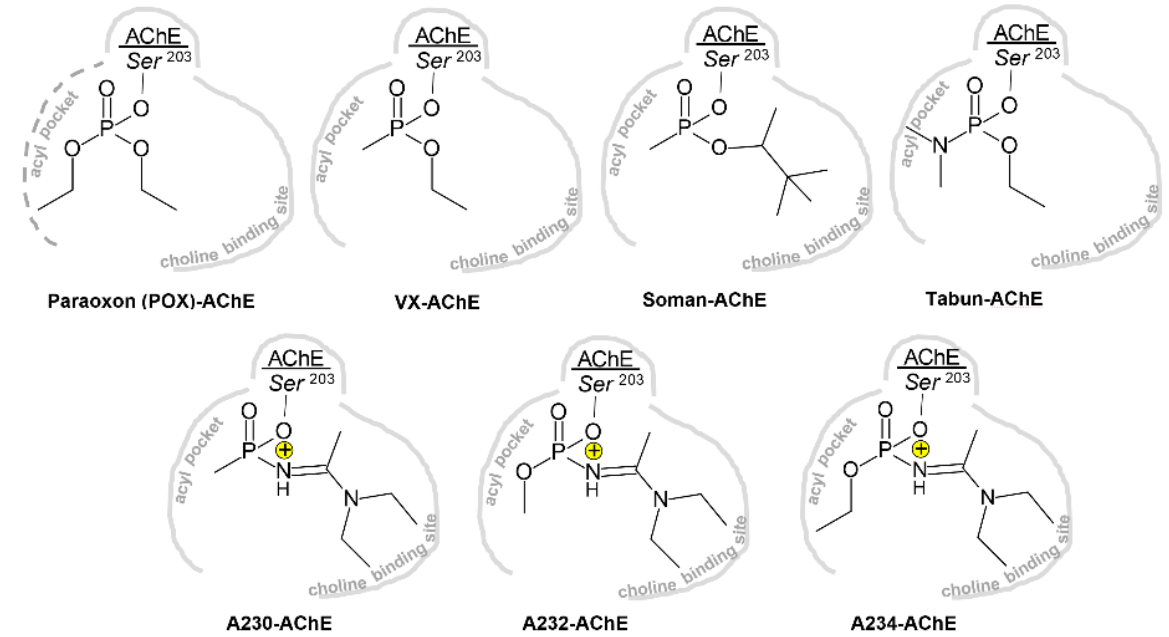
Figure 2. Schematic representation of OP-hAChE conjugates formed by OPs from Figure 1. Orientations of substituents on phosphorus atoms with respect to “acyl pocket”, active Ser203 and “choline-binding site” of hAChE were inferred from respective X-ray structures. Protonation of the imido nitrogen in A-type nerve agent inhibited conjugates is suggested based on semi-empirical calculations.